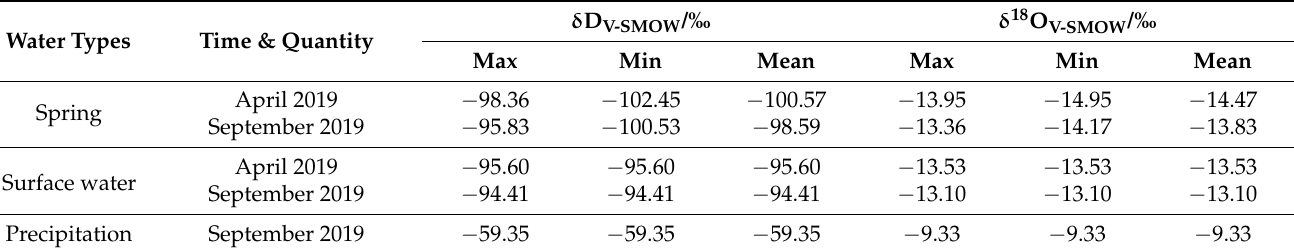
Table 3. Analytical results of stable hydrogen and oxygen isotope.